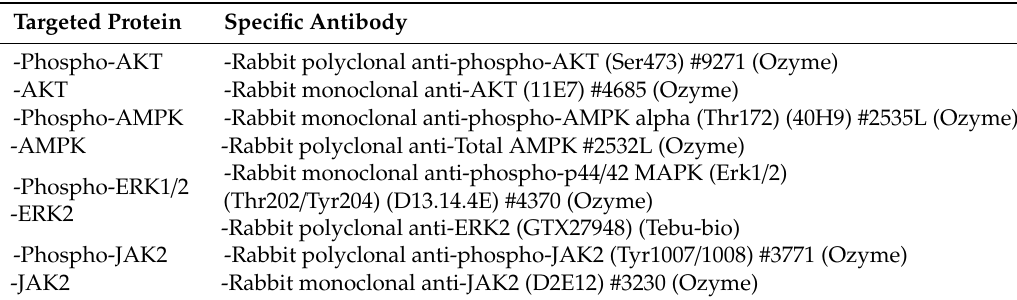
Table 2. Antibodies used for western